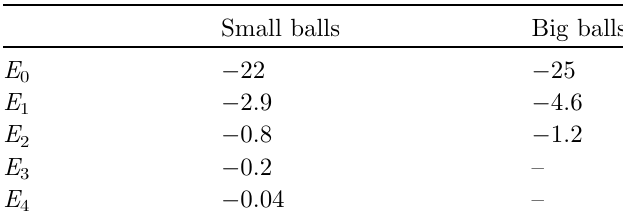
in mJ for big and small balls. n